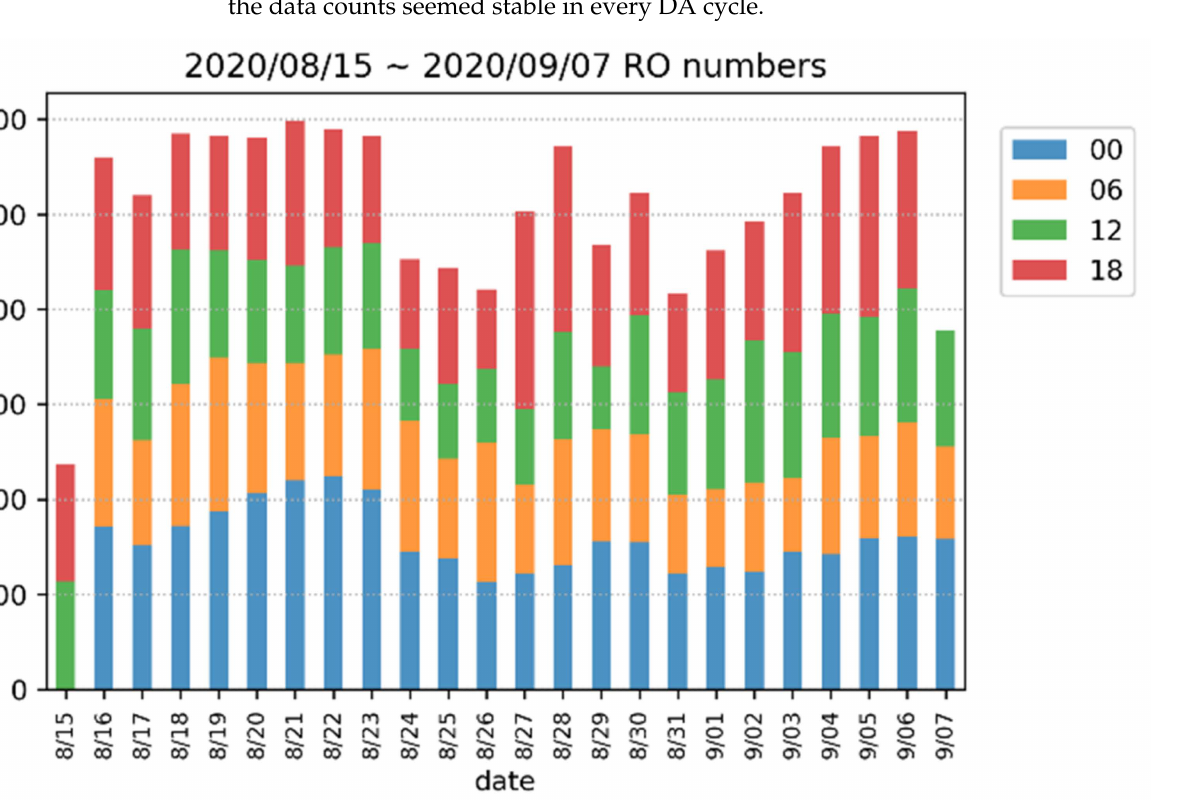
Figure 2. FS7 RO profile counts in CWBWRF domain within ± 3-h data assimilation window for 00/06/12/18 UTC from 1200 UTC 15 August to 1200 UTC 7 September